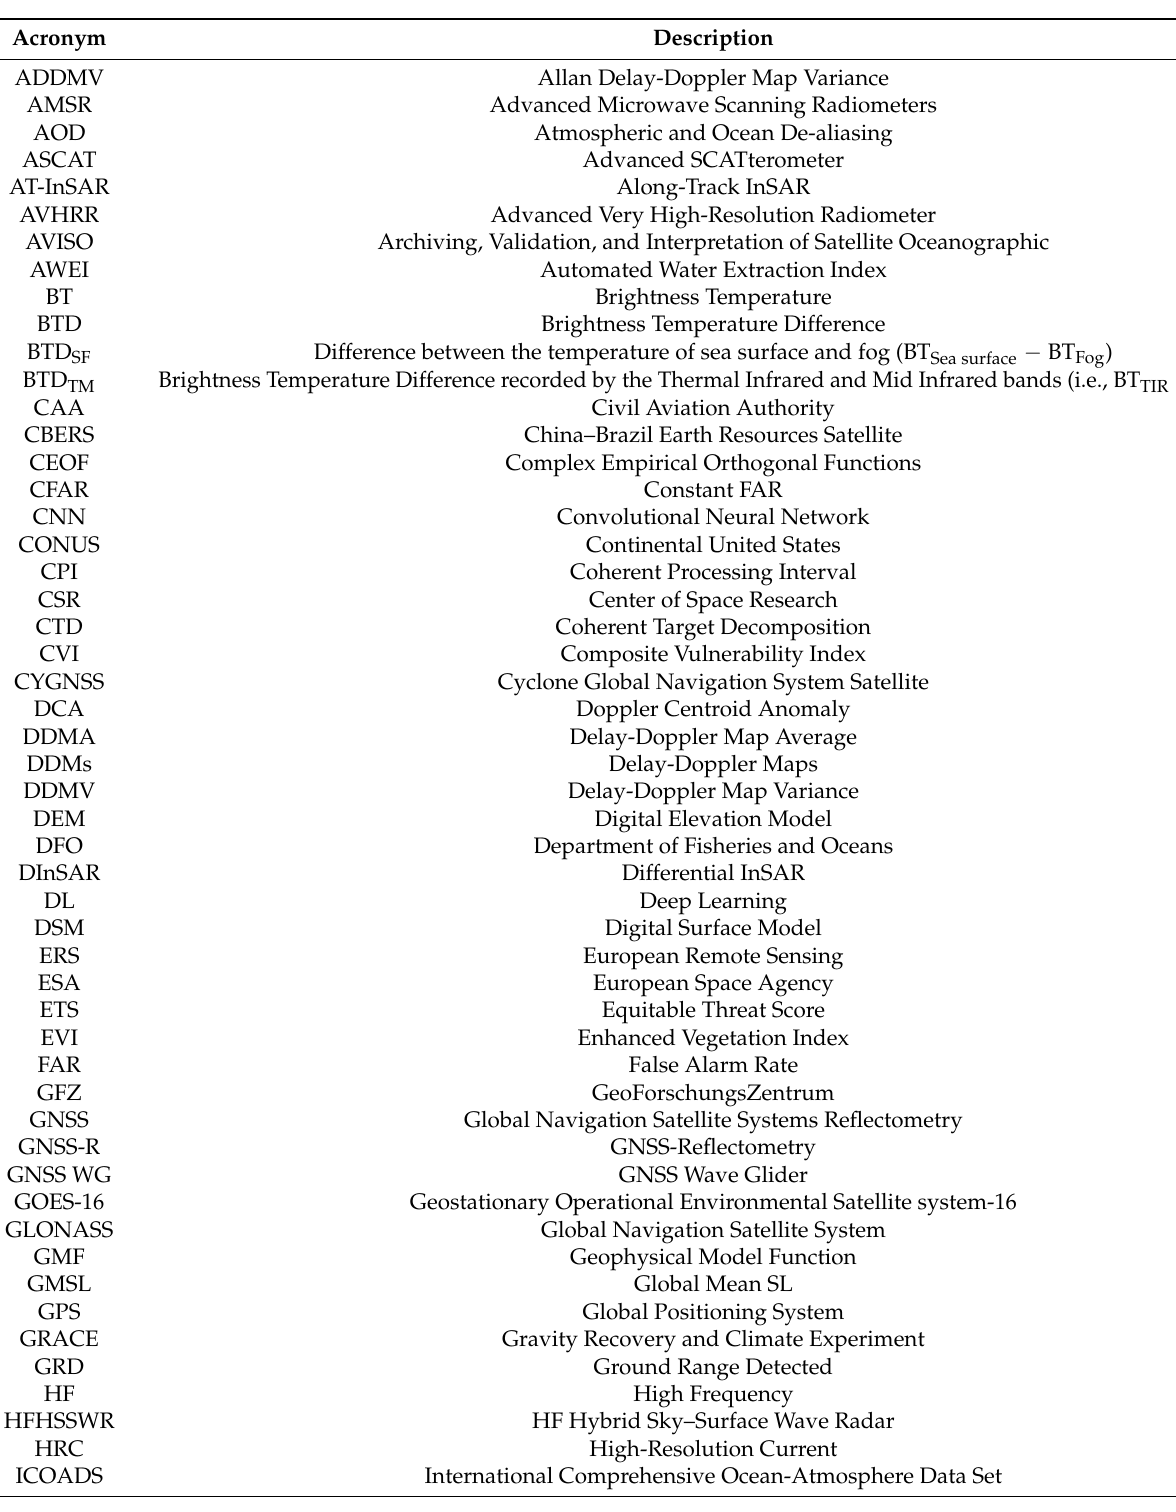
Table A1. Acronyms and corresponding